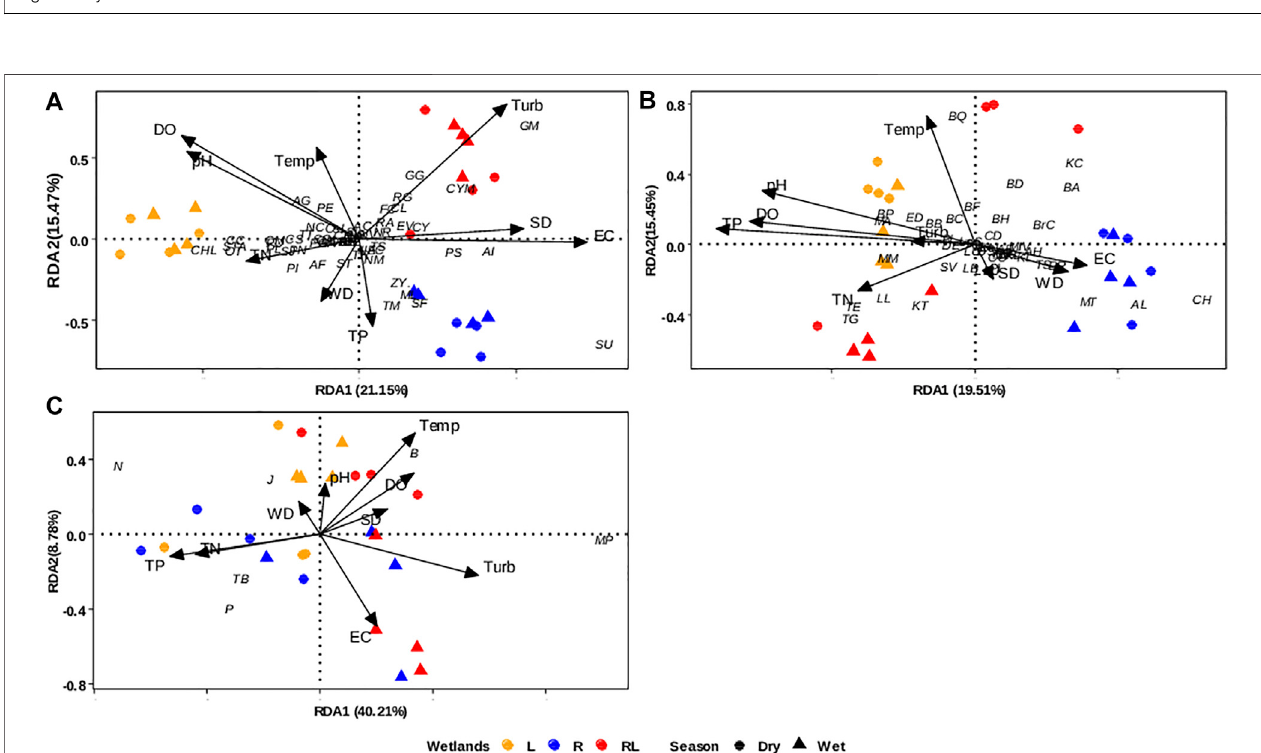
FIGURE.6| TriplotsofRedundancy analysis(RDA)forphytoplanktontaxa (A) ,zooplanktontaxa (B) andReynoldsFunctionalGroups (C) inL=lacustrinewetlands (orange color), R = riverine papyrus swamps (blue color), and RL = river mouth wetlands (red color) during the dry season (circle) and the wet season (triangle); pH, SD sediment depth, WD water depth, EC speci fi c conductance, Turb turbidity, DO dissolve oxygen concentration, and Temp temperature. The full names of the plankton taxa indicated as code are given in Supplementary Tables S3, S4 .